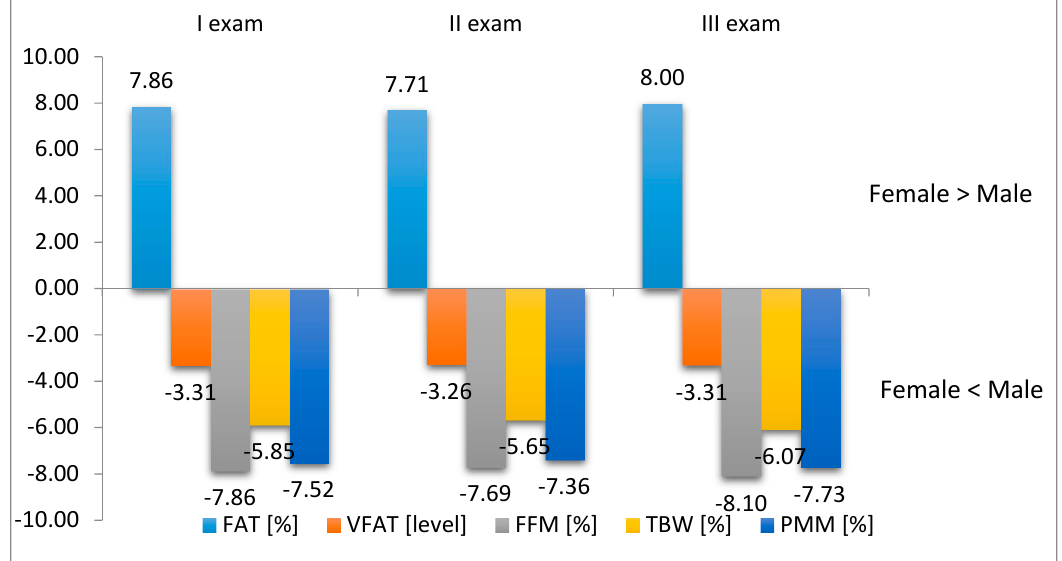
Figure 1. Difference between body mass components versus subjects’ sex. Figure 1. Di ff erence between body mass components versus subjects’ Table 2. Body mass components versus subjects’ age.